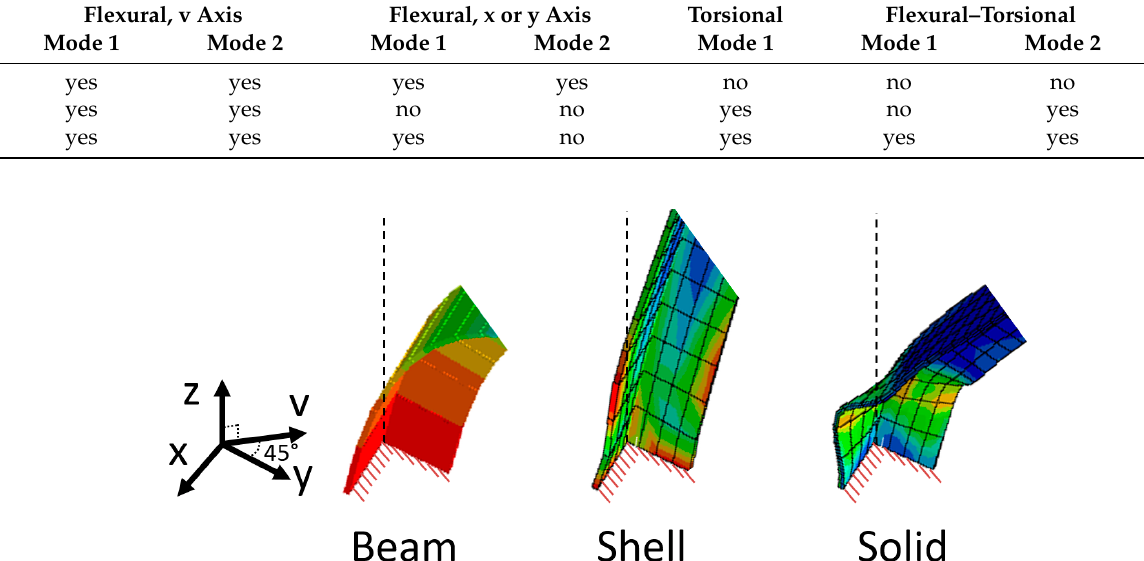
Figure 6. Examples of buckling modes reproduced in an LBA. Flexural modes are characterized by bending in axis x, y or v. Axis x and y are aligned with the flanges; v axis (the one with the weakest moment of inertia) lies 45° to y axis in the x-y plane. The torsional modes have angular deformation in the z-axis, whereas torsional–flexural modes combine it with bending. (Color from blue to red represents the value of e quivalent stresses from low to high). A bi-linear model was sufficient to show the material non-linearity effects and section yielding in the elastic and inelastic buckling areas. The sensitivity to the mesh size and type confirmed the findings of P. Uriz et al. [21]. The local buckling of the flanges can be properly displayed only with fine meshed solid or shell elements. Furthermore, the beam elements do not show any buckling mode other than flexural, while the other element types display torsional and torsional–flexural buckling. The number of elements in the length affects mostly the ability to display local deformation. These mesh types are going